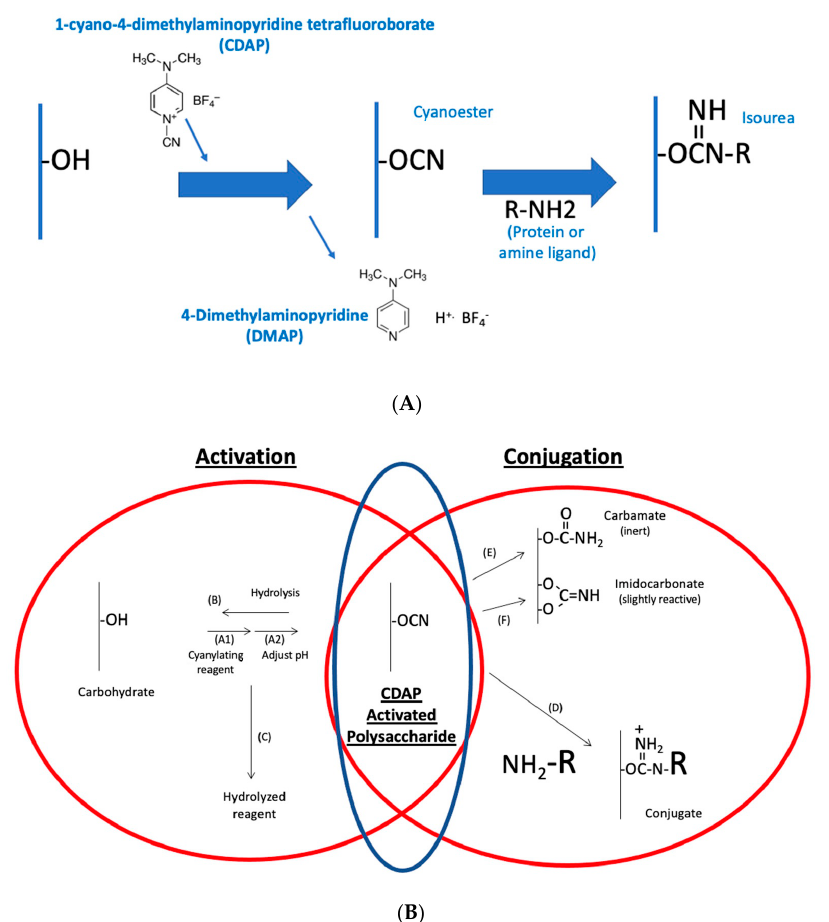
Figure 2. Process of CDAP activation and conjugation, conceptually dividing the two phases. Overview ( A ) and details ( B ) of CDAP activation and conjugation with the chemical structures of CDAP and DMAP, the hydrolysis product. of CDAP and DMAP, the hydrolysis